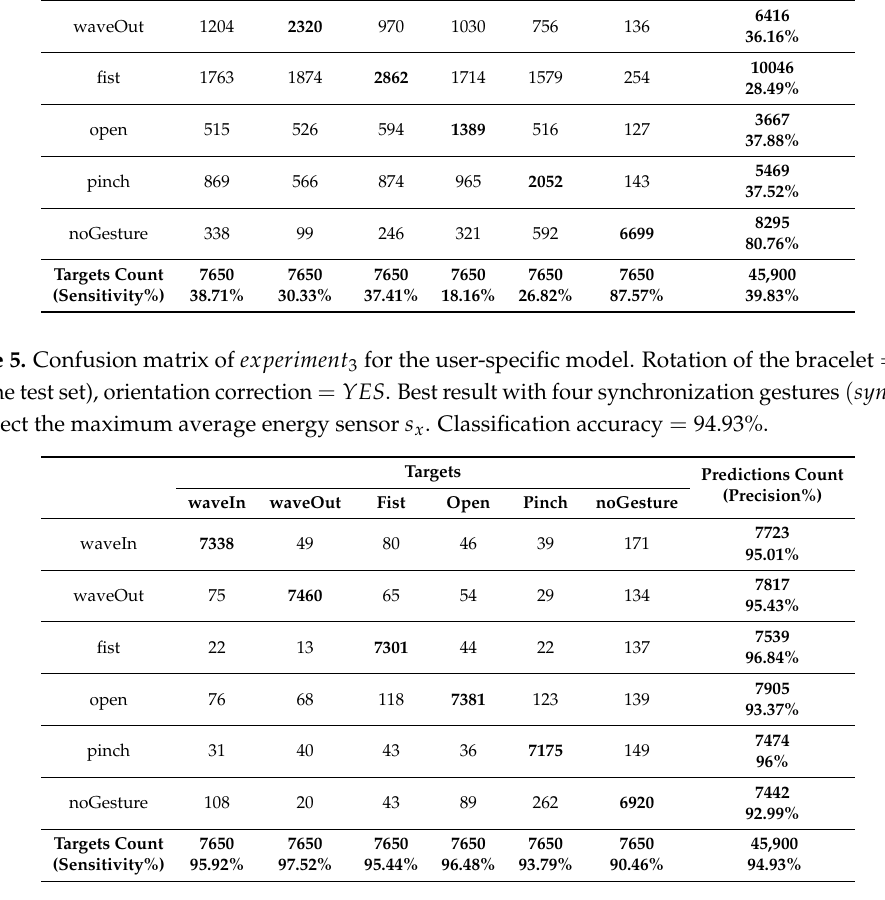
Table 6. Confusion matrix of experiment 4 for the user-specific model. Rotation of the bracelet = YES (on training and test set), orientation correction = YES . Best result with four synchronization gestures ( sync = 4 ) to select the maximum average energy sensor s x . Classification accuracy =